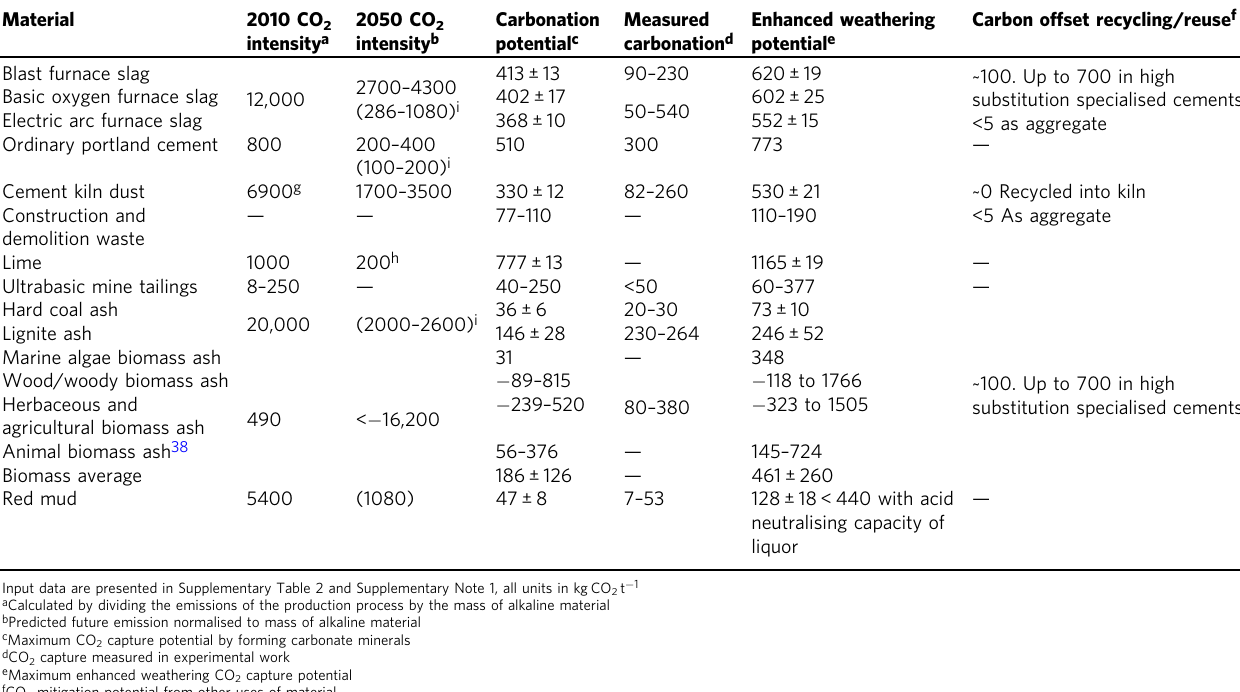
Table 1 Carbon production intensities and sequestration potential of highly alkaline materials, by-products and wastes